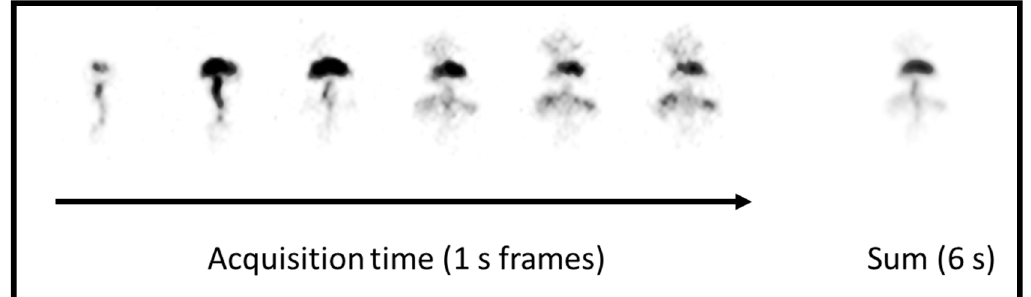
Figure 12. YZ plane reconstructed with PINV z + 2D-PINV of a 13 g mouse injected with 120 µ Ci of